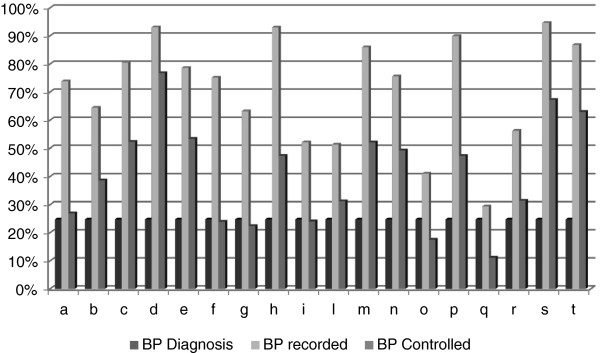
Baseline performances of the 18 participanting GPs (letters identify GPs).